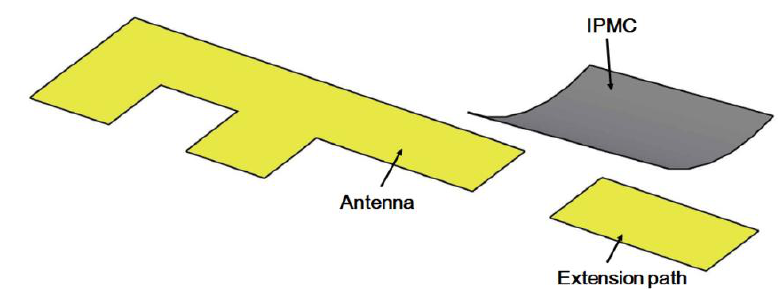
Figure 1. Schematic representation of one IPMC switch moved to control the operating band of an